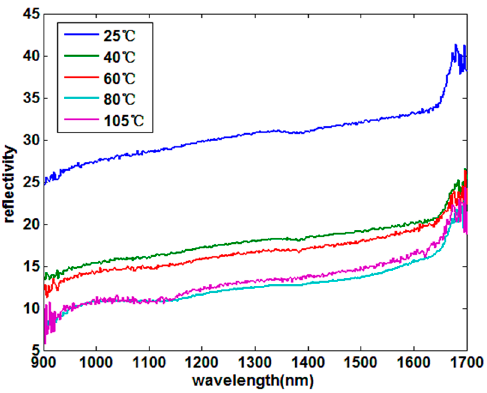
Figure 2. The average spectral of different drying temperatures when the soil nitrogen concentration is 2.5 g/kg.